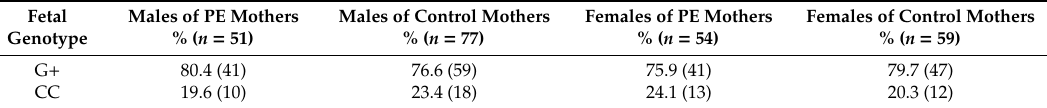
Table 3. Frequency distribution of High and Low CD99 expresser genotypes among subgroups of